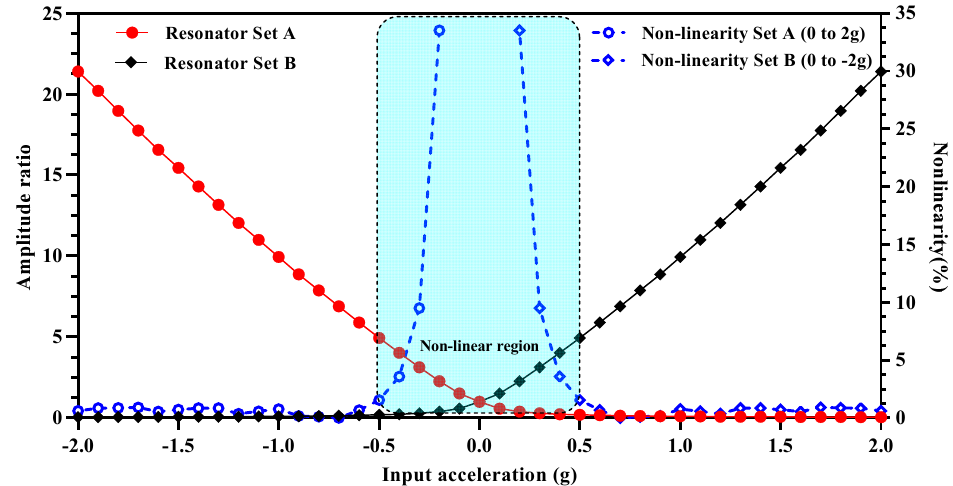
Figure 8. Nonlinearity in the amplitude ratio values for the 3-DoF resonators in Set A and Set B of the MEMS accelerometer.